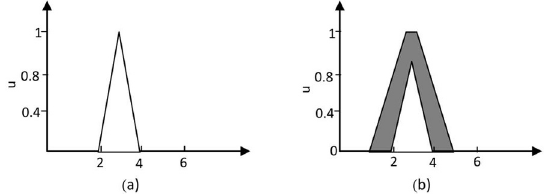
Figure 4. (a) Type-1 membership function, (b) Footprint of